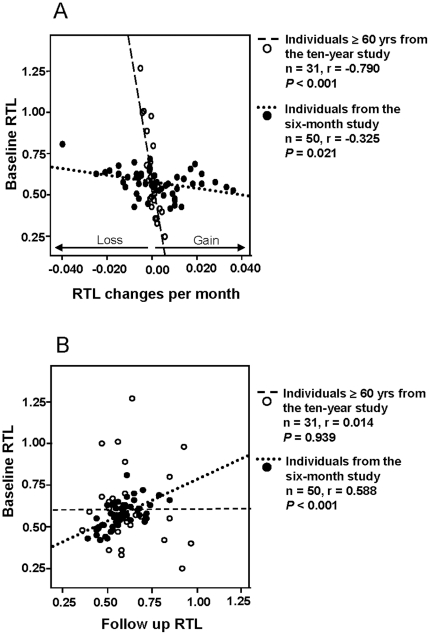
Data comparisons between the 6 month study and the 10 year study.A. Baseline RTL versus RTL changes per month. Monthly RTL changes were greater in the 6 month study compared to the 10 year study. B. Baseline RTL versus follow up RTL, showing a significant correlation in the 6 month study but not in the 10 year study.